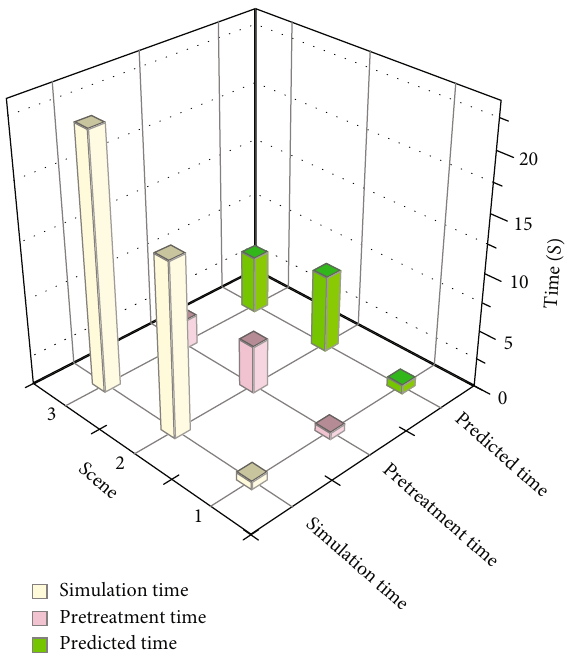
Figure 7: Computational e ffi ciency test diagram of fl uid animation simulation under